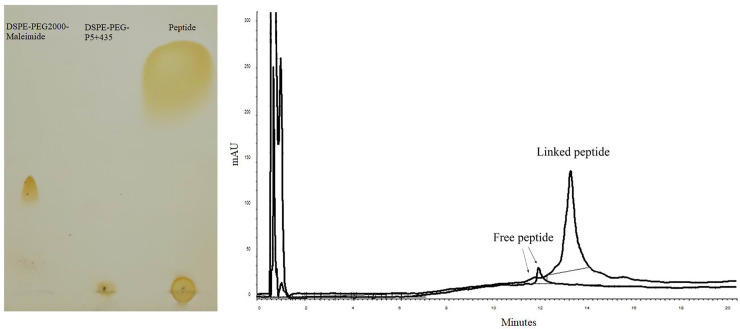
Confirmation of conjugation between P5+435 peptide and Maleimide-PEG-DSPE by using TLC (A) and HPLC (B) analyses.